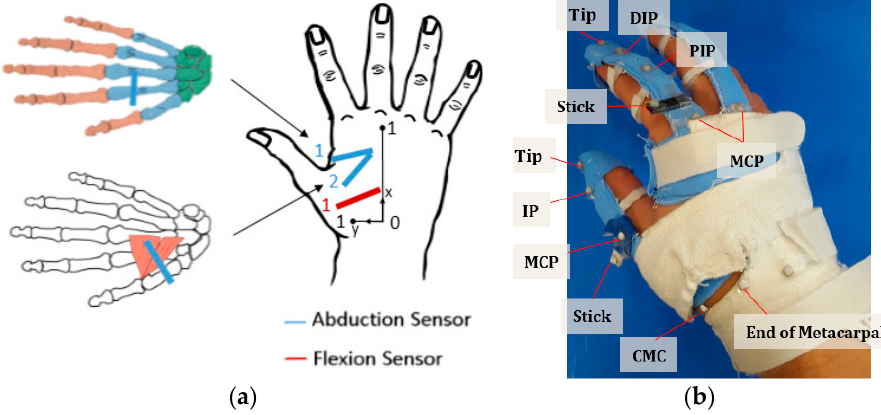
Figure 9. Sensor and marker positions for the experiment: ( a ) sensor locations; ( b ) marker placement for CMC-joint-angle estimation.